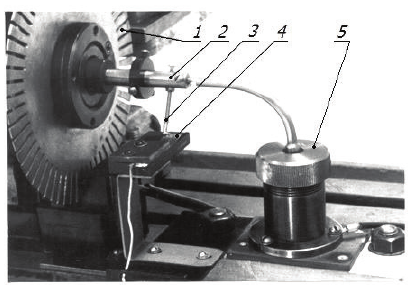
Figure 7. Counterparts: а, b – for boundary lubrication; c – hydrodynamic lubrication (thermocouple fixed to the surface). Dimensions in